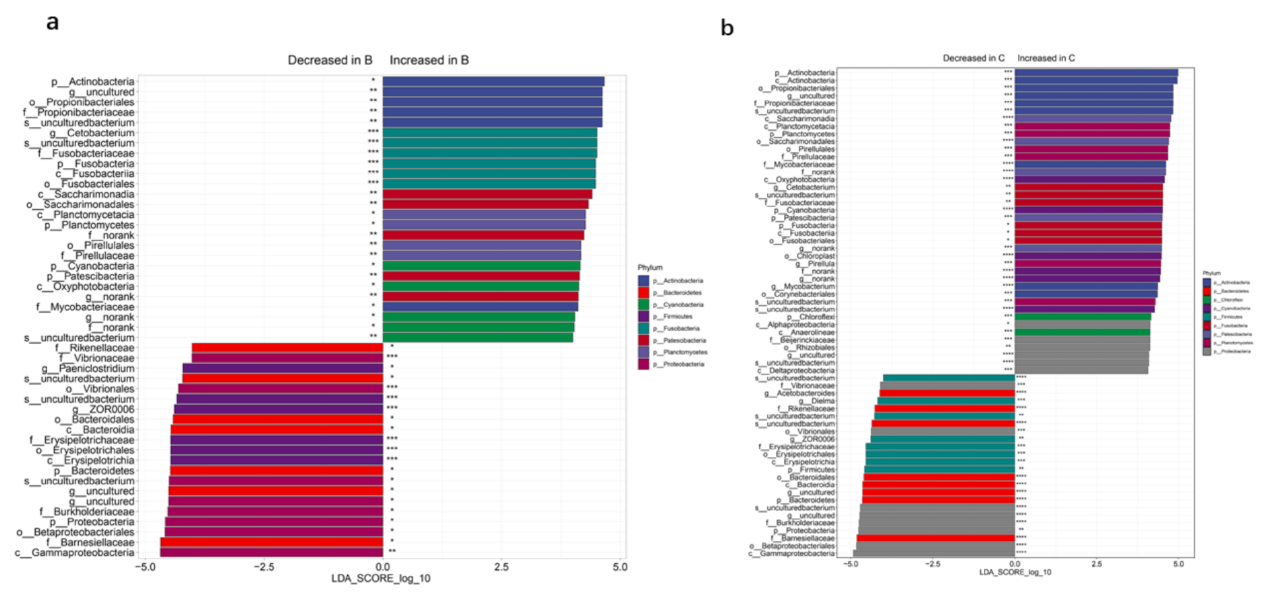
Figure 3. Bacteria taxa differentially expressed in fish intestinal microbiota of the three groups of bighead carp. ( a ) Differen- tially expressed bacteria identified in group B (nature live food + fish feed, n = 15) compared to group A (nature live food only, n = 9). ( b ) Differentially expressed bacteria identified in group C (nature live food + fish feed + lactic acid bacteria, n = 15). The histograms represent the linear discriminant analysis (LDA) score computed for taxa differentially abundant between the different groups. *** p < 0.001; ** p < 0.01; * p <